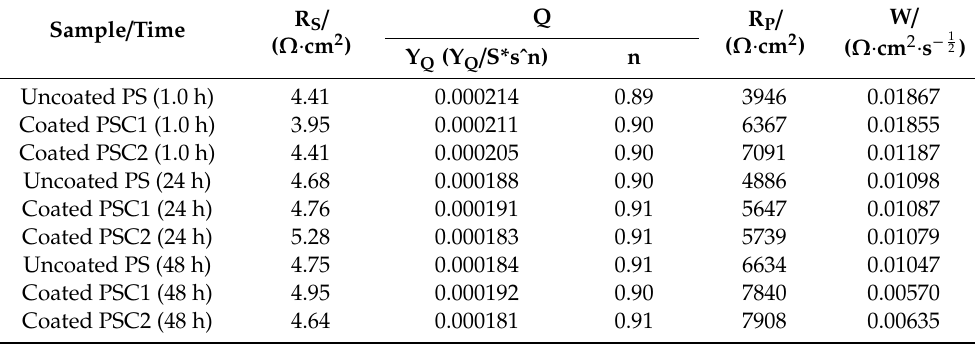
Table 3. EIS data obtained for the uncoated and coated steel samples after di ff erent immersion periods in 4% NaCl